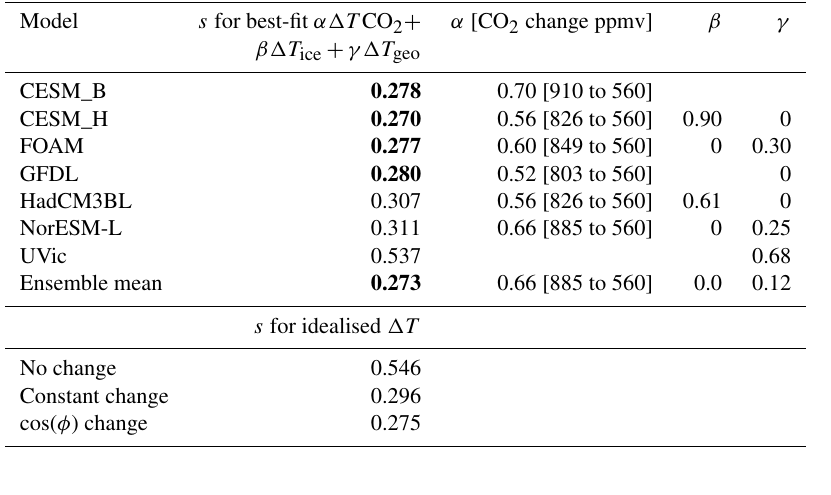
Table 4. Skill scores, s , for the best-fit modelled changes in response to a combination of CO 2 , ice and palaeogeographic forcing, for each model and for the ensemble mean (a lower value of s represents a better fit to data). Also shown are the values of α , β and γ that give the best fit, and the CO 2 change corresponding to α , assuming a post-EOT value of 560ppmv. Also shown are the values of s for three idealised SAT changes. Changes highlighted in bold are better than or equal to the idealised constant-change case, while CESM_H and the ensemble mean achieve better than the idealised cos( φ ) case.